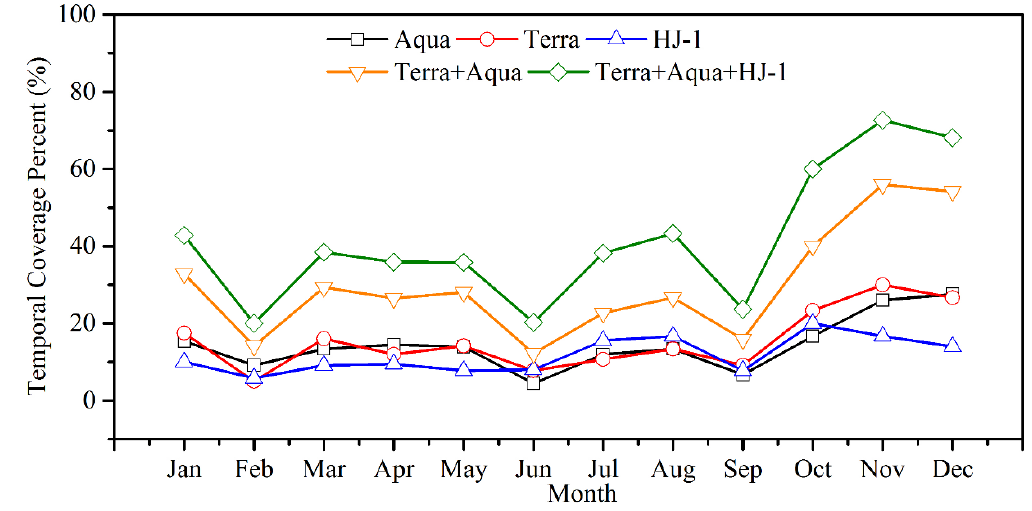
Figure 13. Temporal coverage in percent for different satellite sensors over Poyang Lake (data obtained from 2009 to 2016).